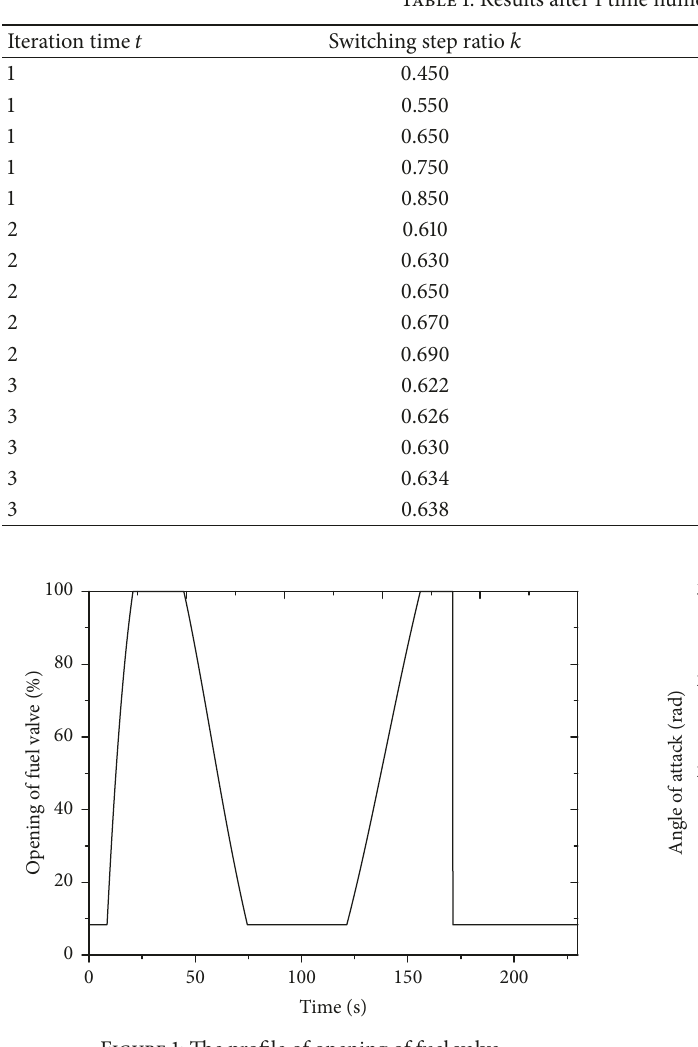
Figure 1: The profile of opening of fuel valve. Figure 2: The profile of the angle of attack.